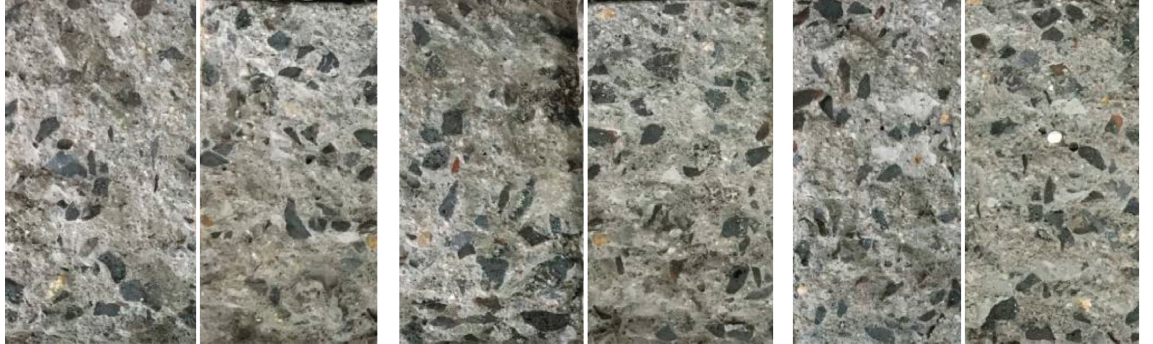
Figure 24: Fractured surface in the test.